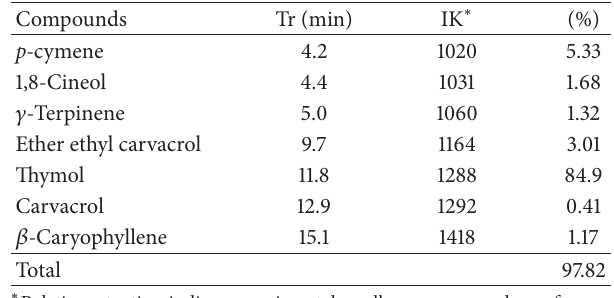
Table 1: Chemical components of Lippia sidoides fresh leaves essential